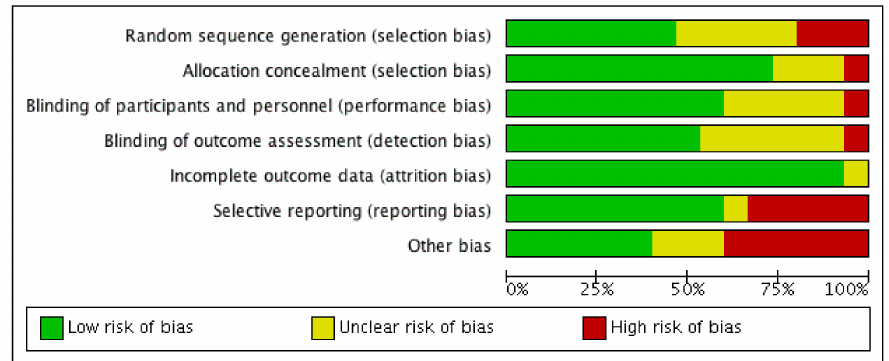
Figure 3. Risk of bias graph expressed as